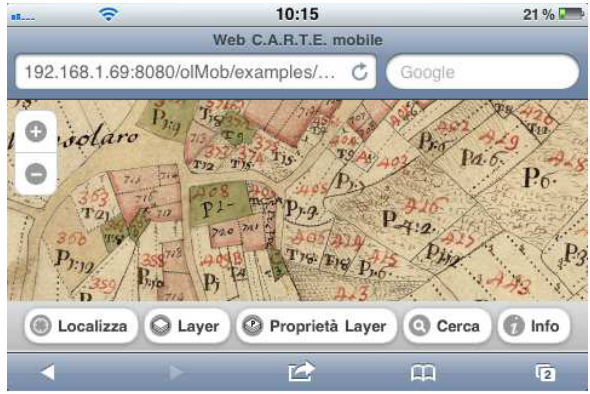
Figure 4. 2D visualization of a Theresian cadastral map in the web client for mobile devices